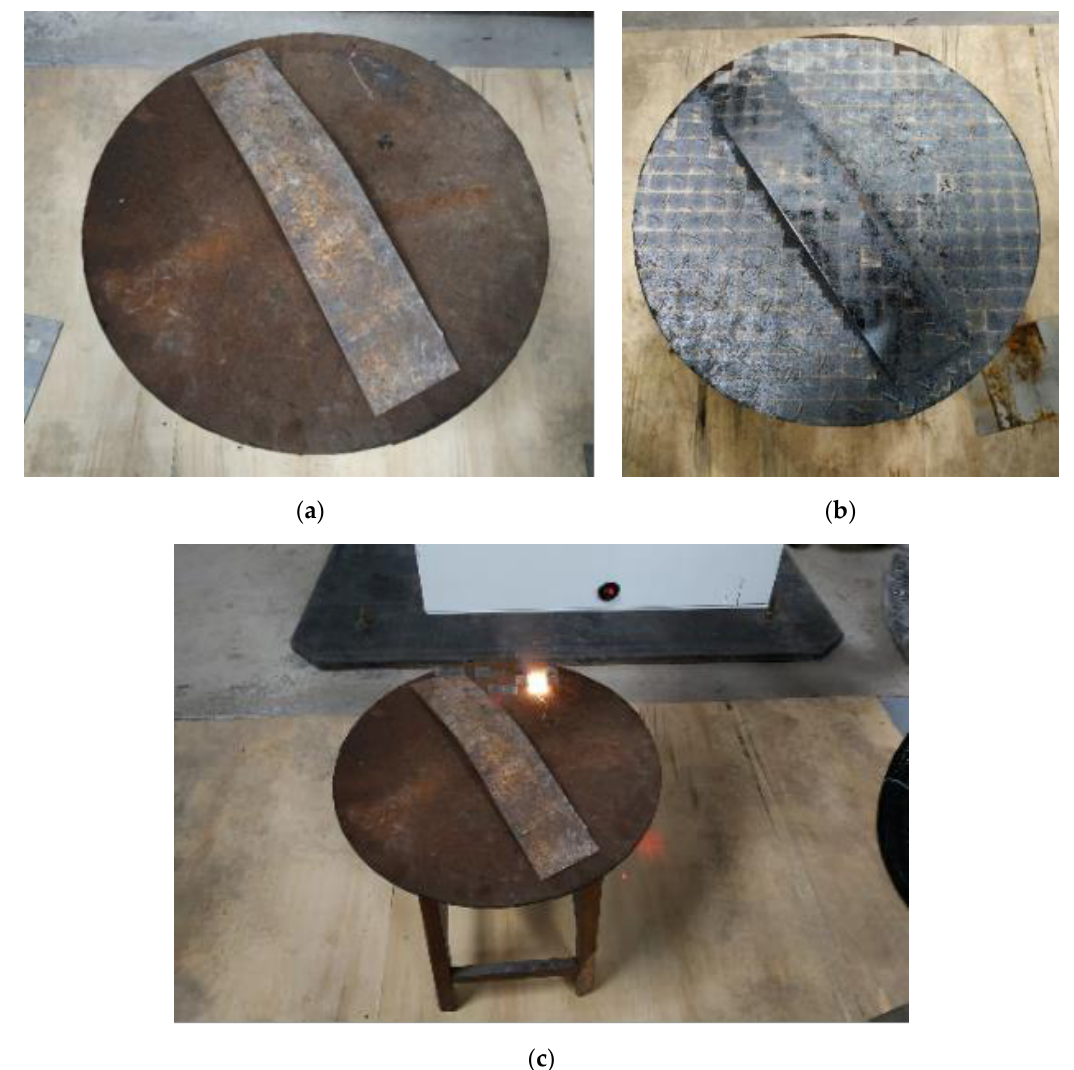
Figure 10. Effect of laser cleaning: ( a ) workpiece before cleaning, ( b ) workpiece after cleaning, and ( c ) Figure 10. Effectoflasercleaning: ( a )workpiecebeforecleaning,( b )workpieceaftercleaning,and( c )workpiece during workpiece during cleaning.